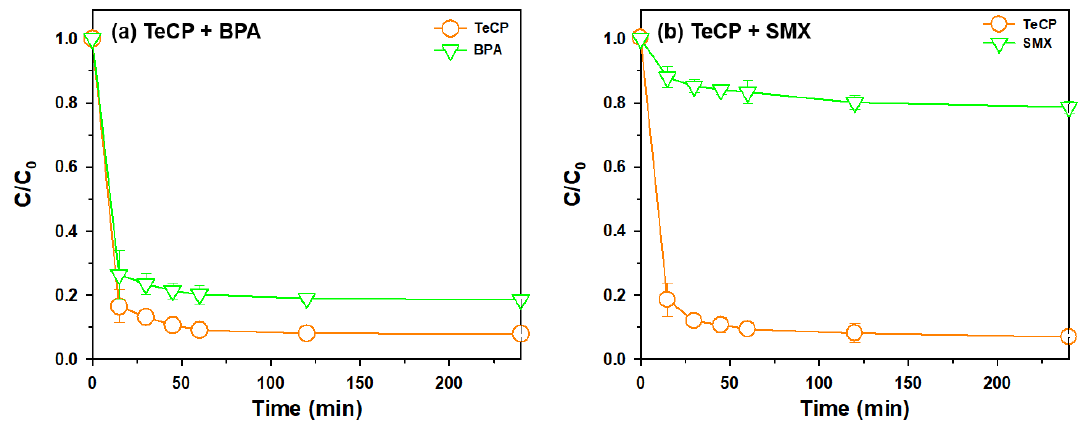
Figure 10. E ff ect of contact time on the uptake of TeCP with the presence of ( a ) BPA and ( b ) SMX on AB-Fe 3 O 4 at pH 3.5 ( C 0 = 5 mg / L, V = 30 mL, adsorbent mass 30 mg, temperature = 25 ± 1 ◦ C, and agitation speed = 300